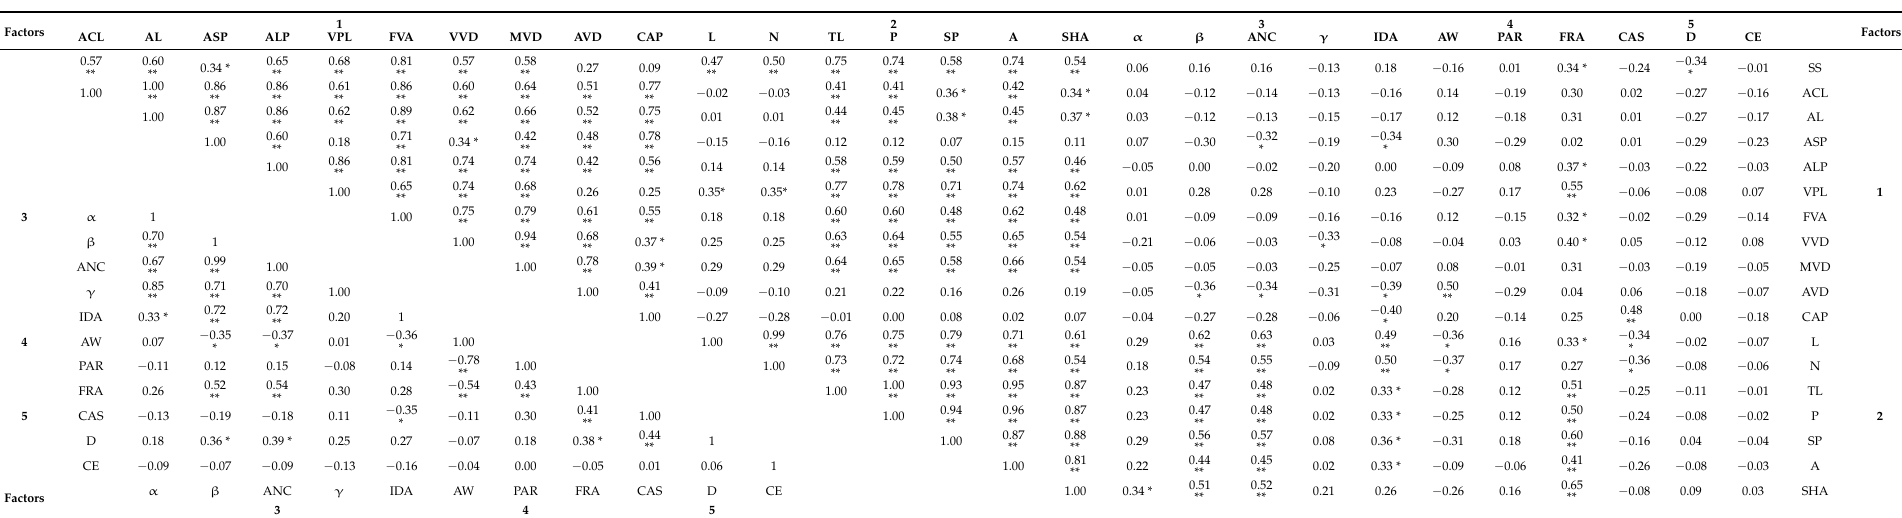
Table 4. Correlations among path indicators and service